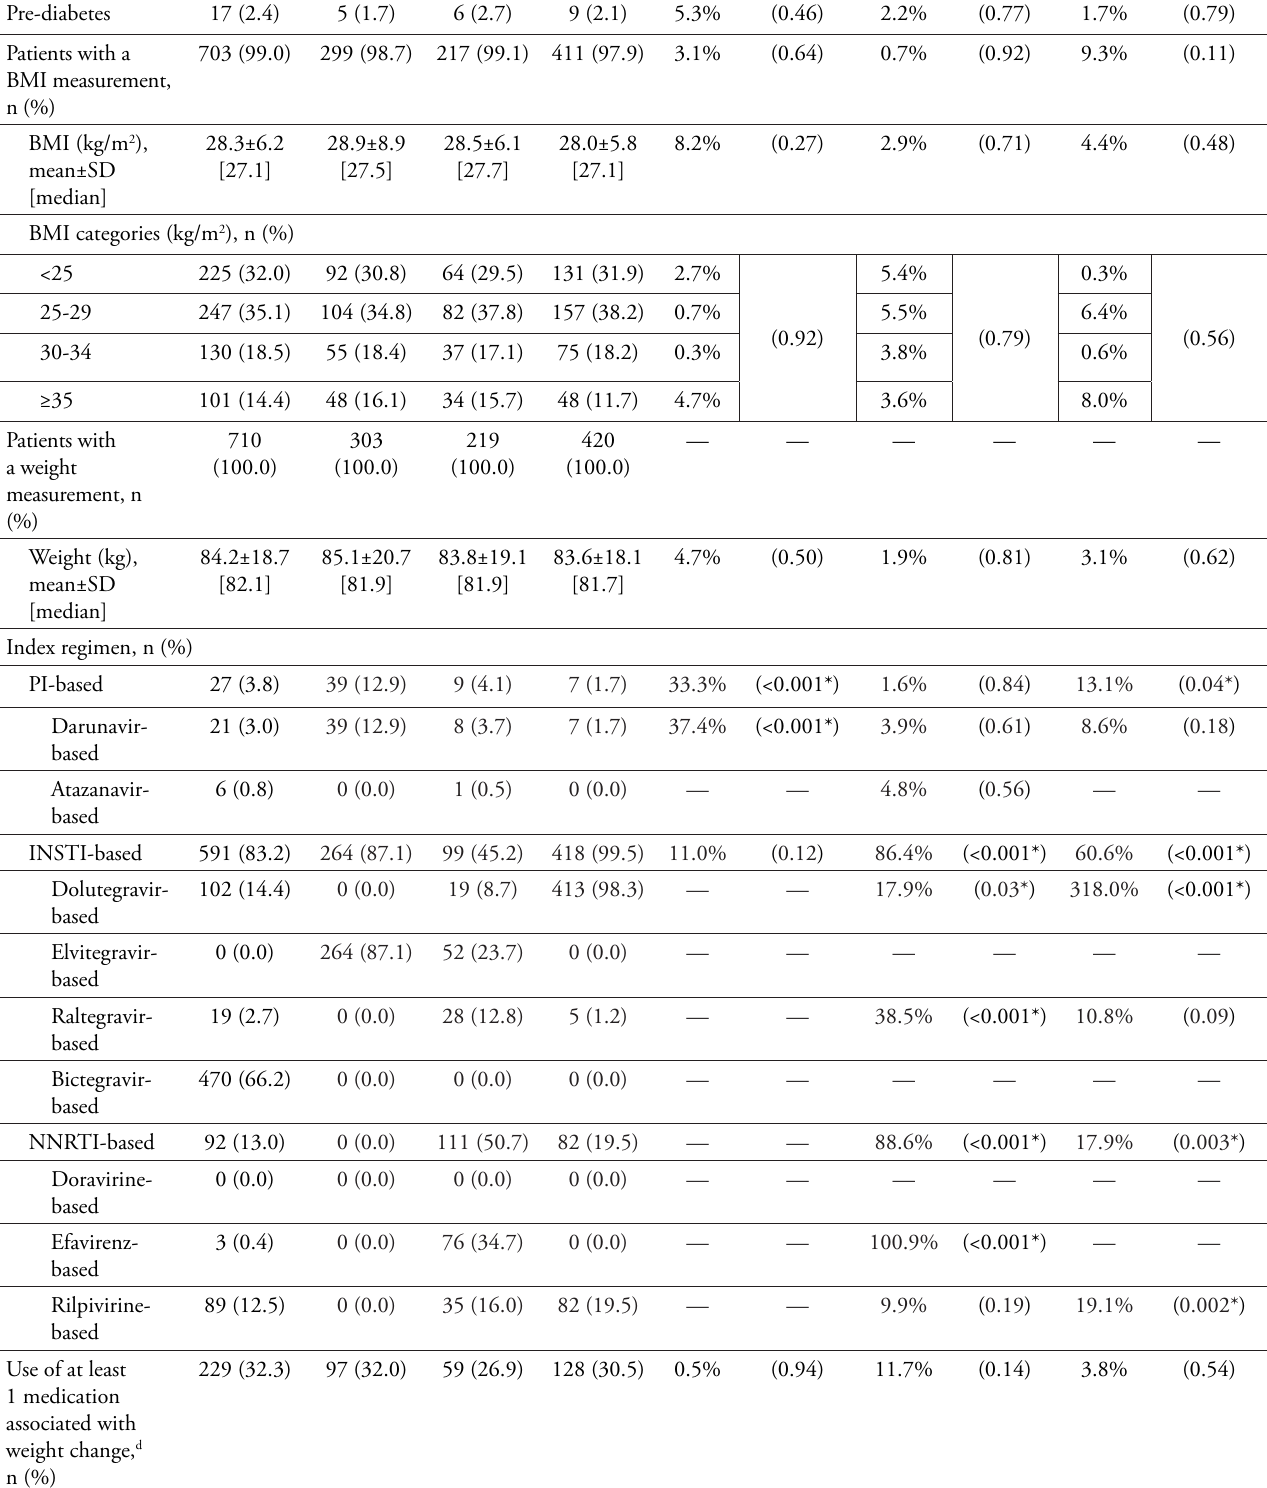
Table 2 for the complete list of mental health–related comorbidities. c Based on the methodology described in Quan et al. 13 d See Supplementary Table 3 for the full list of medications associated with weight